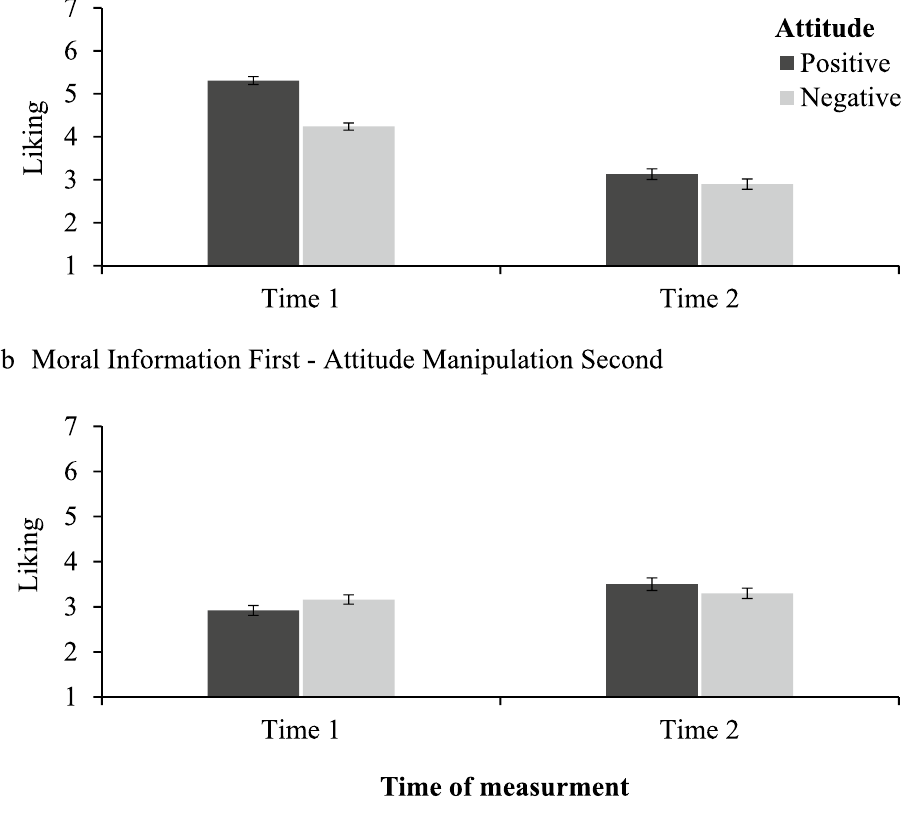
Figure 2. Mean liking judgments at Time 1 and Time 2 as a function of the sequence and attitude manipulation. Higher scores indicate more positive judgments of moral character. The error bars represent one standard